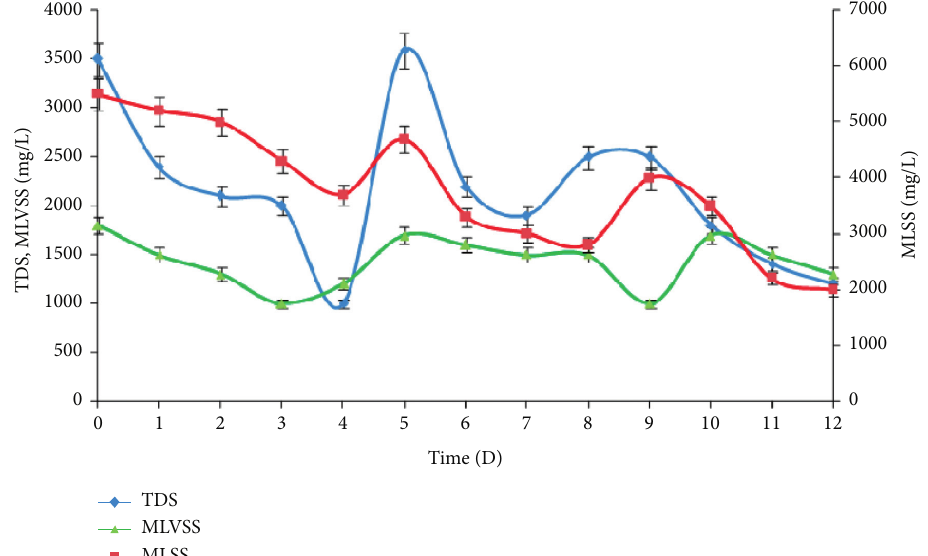
Figure 7: Removal of TDS, MLSS, and MLVSS in the anaerobic treatment of synthetic textile effluent containing 500mg/L of mixed azo dyes in